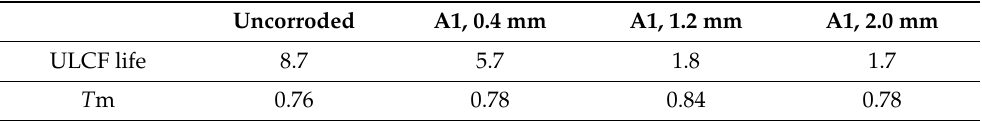
Table 6. Results of simulation of ULCF crack-initiation life of steel piers with uniform corrosion.